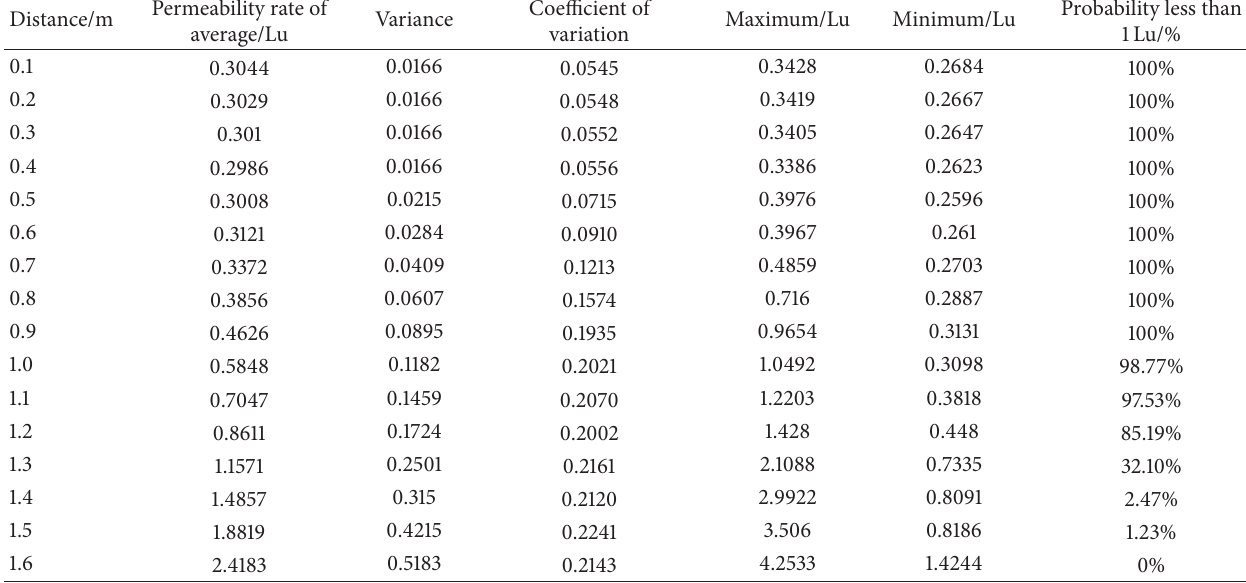
Table 3: Statistical distribution of permeability rate after grouting in Stage 9 at different distances.